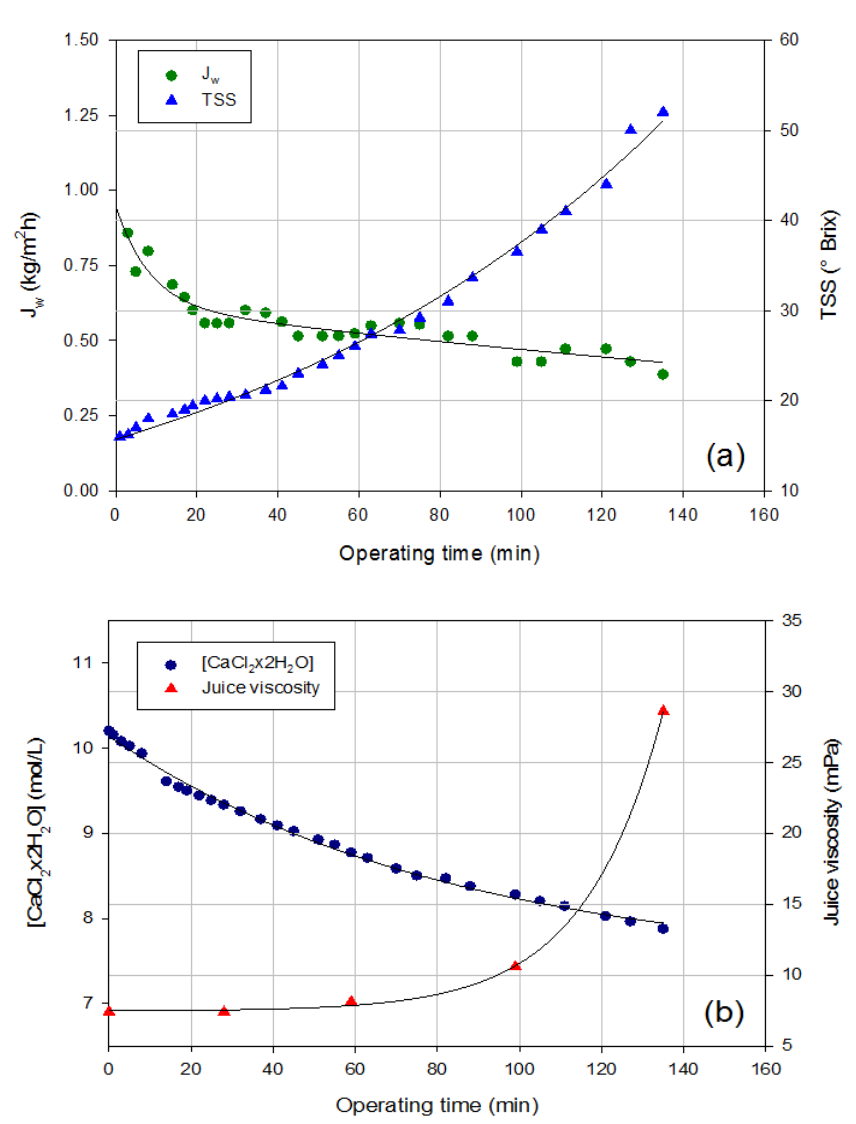
Figure 7. Concentration of pomegranate juice by OD. Time evolution of ( a ) evaporation flux and total soluble solids (TSS); ( b ) concentration of stripping solution and juice viscosity (adapted from [126]).